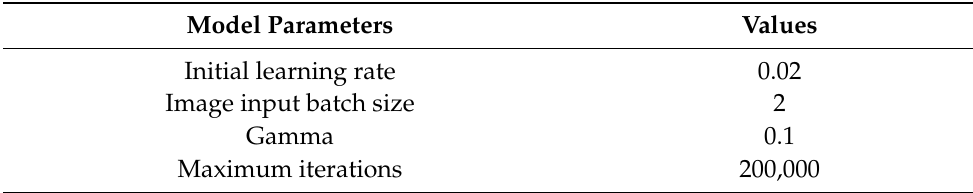
Table 2. Distribution of the